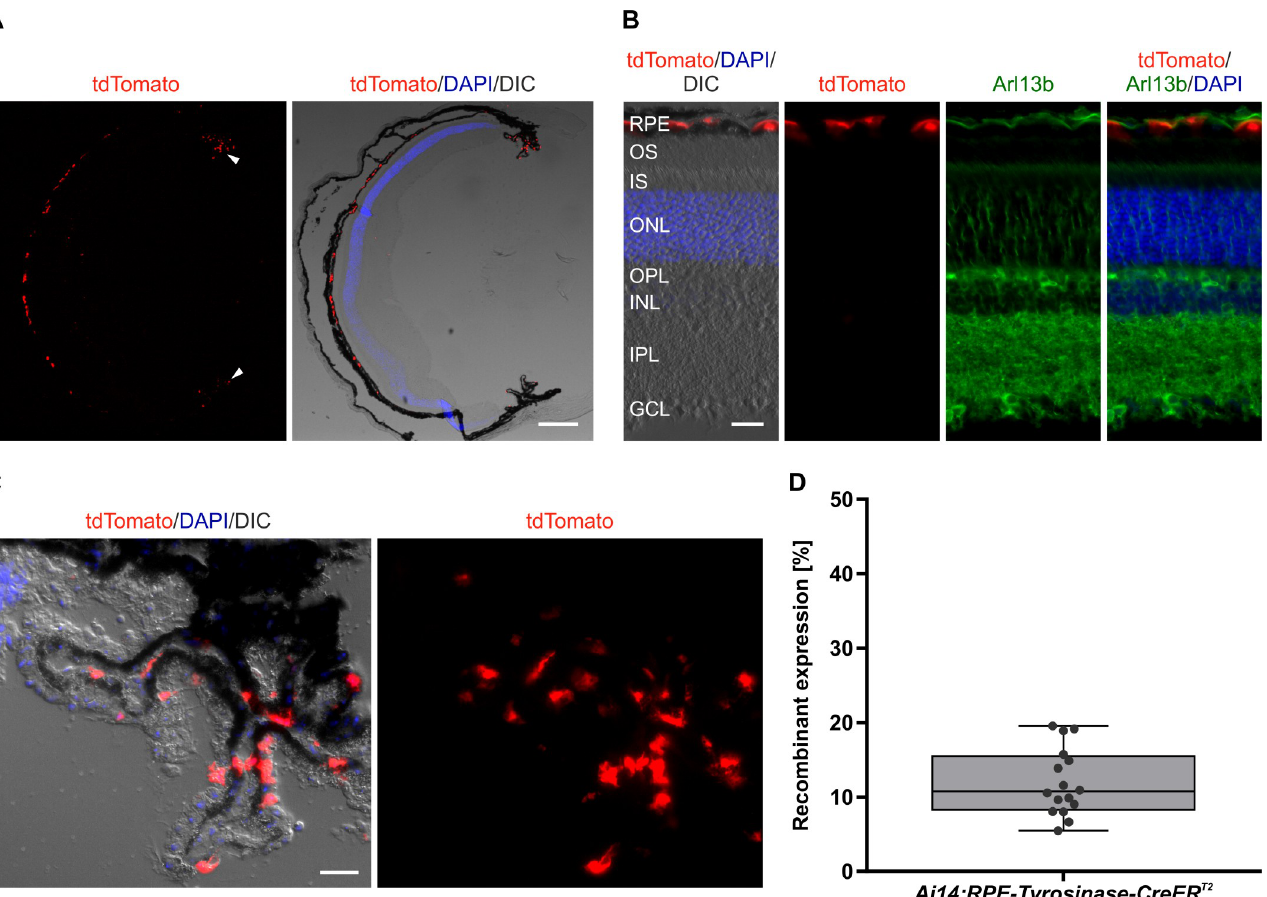
Fig 2. Cre-mediated recombinant expression in the RPE of adult Ai14;RPE-Tyrosinase-CreEr T2 mice. A, B: Localization of tdTomato expression in an adult eye upon Cre activity in longitudinal cryosections stained with DAPI (blue) and Arl13b (green) to visualize the connecting cilium (B), respectively. Differential interference contrast (DIC) image was overlaid with the DAPI staining and red fluorescent tdTomato expression. Cre activity resulted in tdTomato expression, which is seen in the RPE and to a lesser extent in the ciliary body (white arrowheads). C: Cre activity resulted in simultaneous tdTomato expression in the ciliary body. D: Quantification of tdTomato expression in the ciliary body. n = 16 ciliary bodies from three individual animals. RPE: Retinal pigment epithelium, OS: Outer segments, IS: Inner segments, ONL: Outer nuclear layer, OPL: Outer plexiform layer, INL: Inner nuclear layer, IPL: Inner plexiform layer, GCL: Ganglion cell layer. Scale bars: (A) 250 μ m, (B) 25 μ m, (C) 25 μ m.